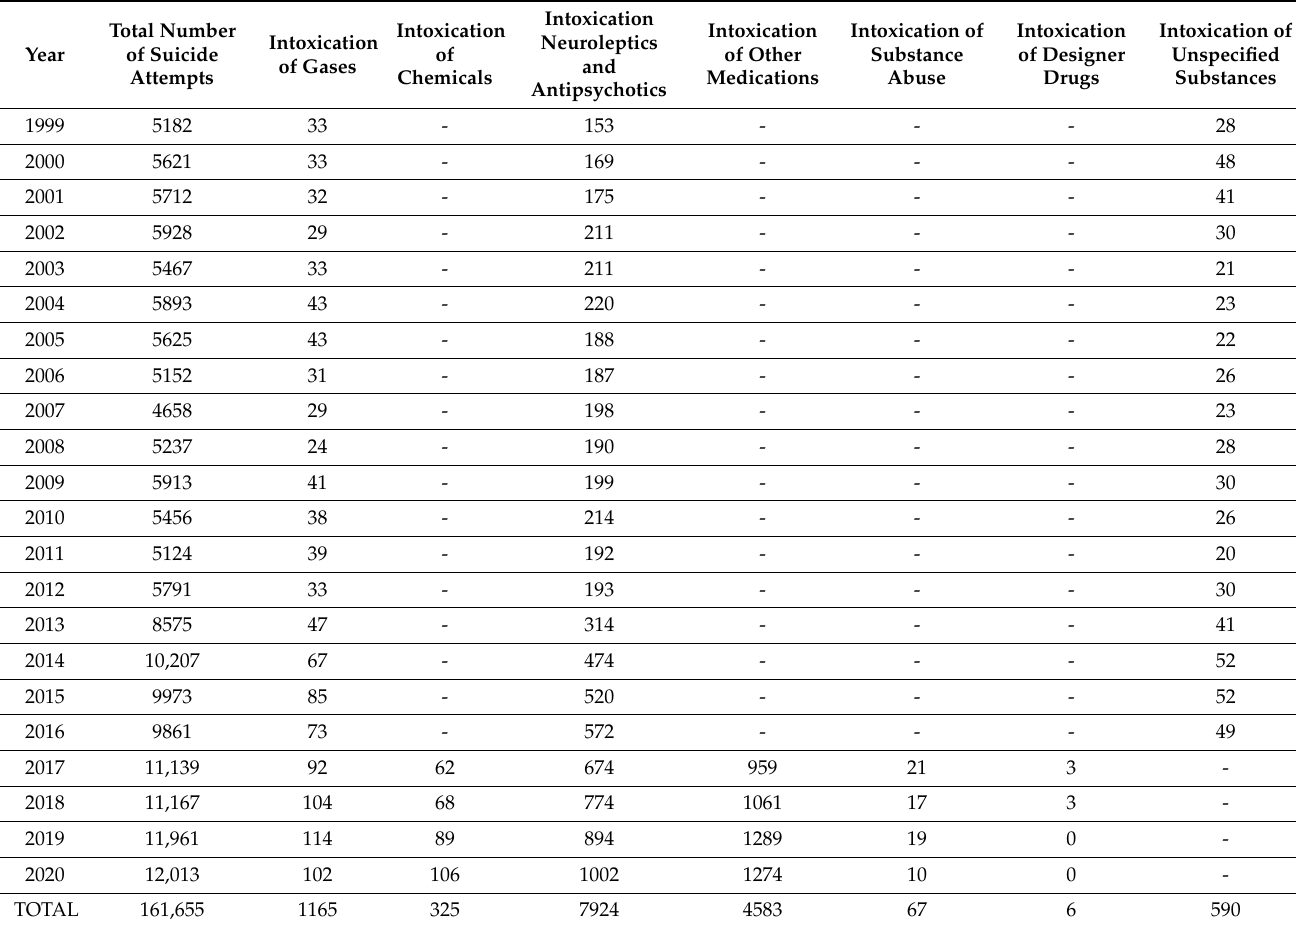
Table 1. Substances causing suicide attempts in 1999–2020 in Poland (source: own study based on data by GPHP).